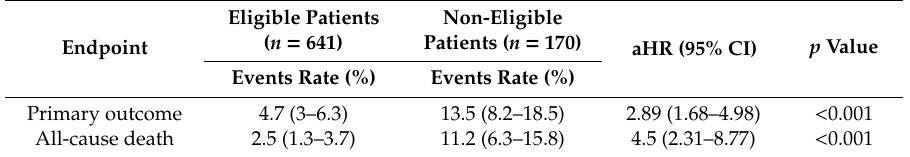
Figure 4. The association between long-term outcomes and eligibility: ( A ) the cumulative incidence of the composite outcome of death from cardiovascular causes and new-onset acute coronary syndrome in the eligible group and the non-eligible group; ( B ) the cumulative incidence of all-cause death in the eligible group and the non-eligible group. Table 3. Clinical outcomes and hazard ratios according to eligibility.